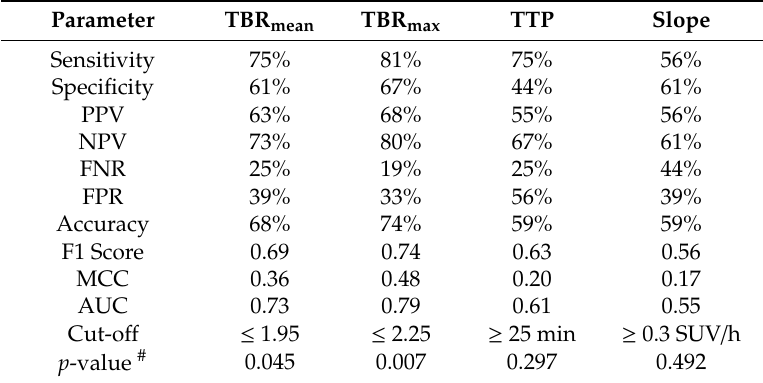
Table 2. Classification results of conventional FET PET parameters for di ff erentiating pseudoprogression from early tumor